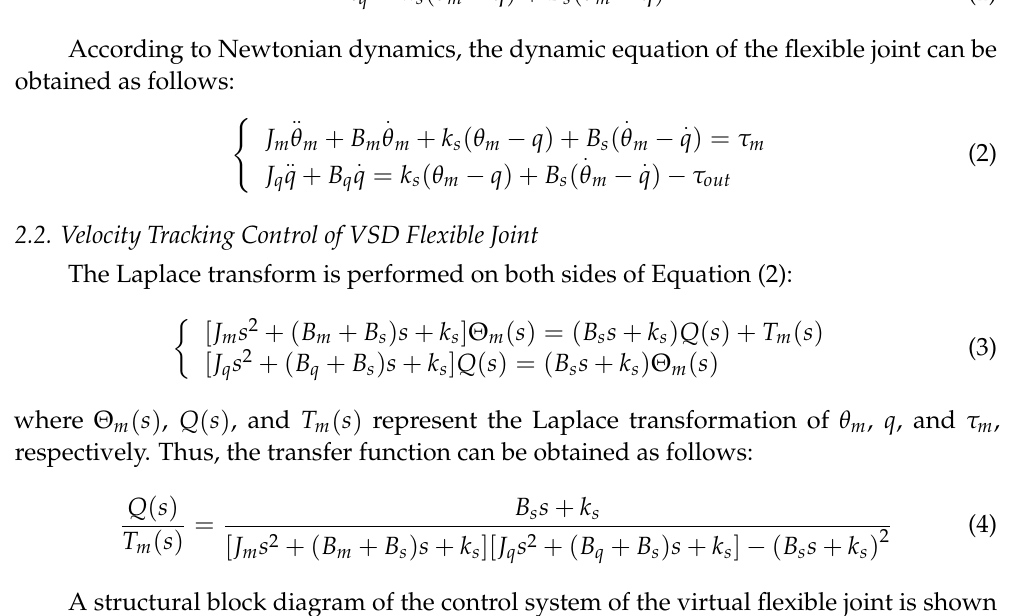
Figure 1. Schematic diagram of VSD flexible joint.